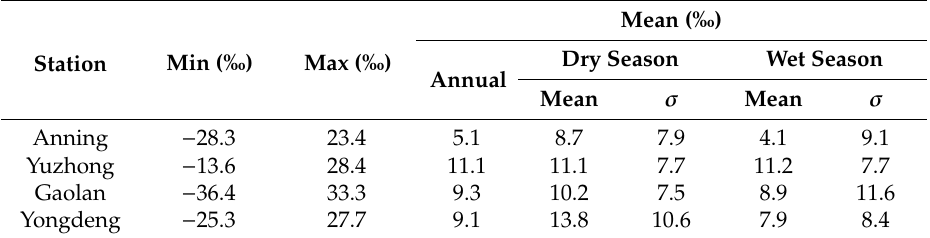
Table 2. Minimum, maximum, mean values and standard deviation ( σ ) of d value for the wet (May to September) and dry (October to April) seasons at the four stations in the Lanzhou